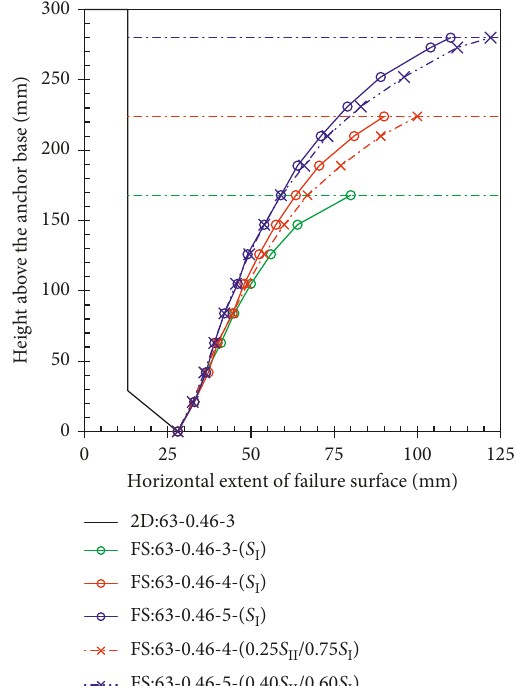
Figure 9: Failure surface around panel 2D:63-0.46-3-( S comparison to FS:63-0.46-4-( S I ) and FS:63-0.46-4-(0.25 S II /0.75 S I ) and FS:63-0.46-5-( S I ) and FS:63-0.46-5-(0.40 S II /0.60 S I